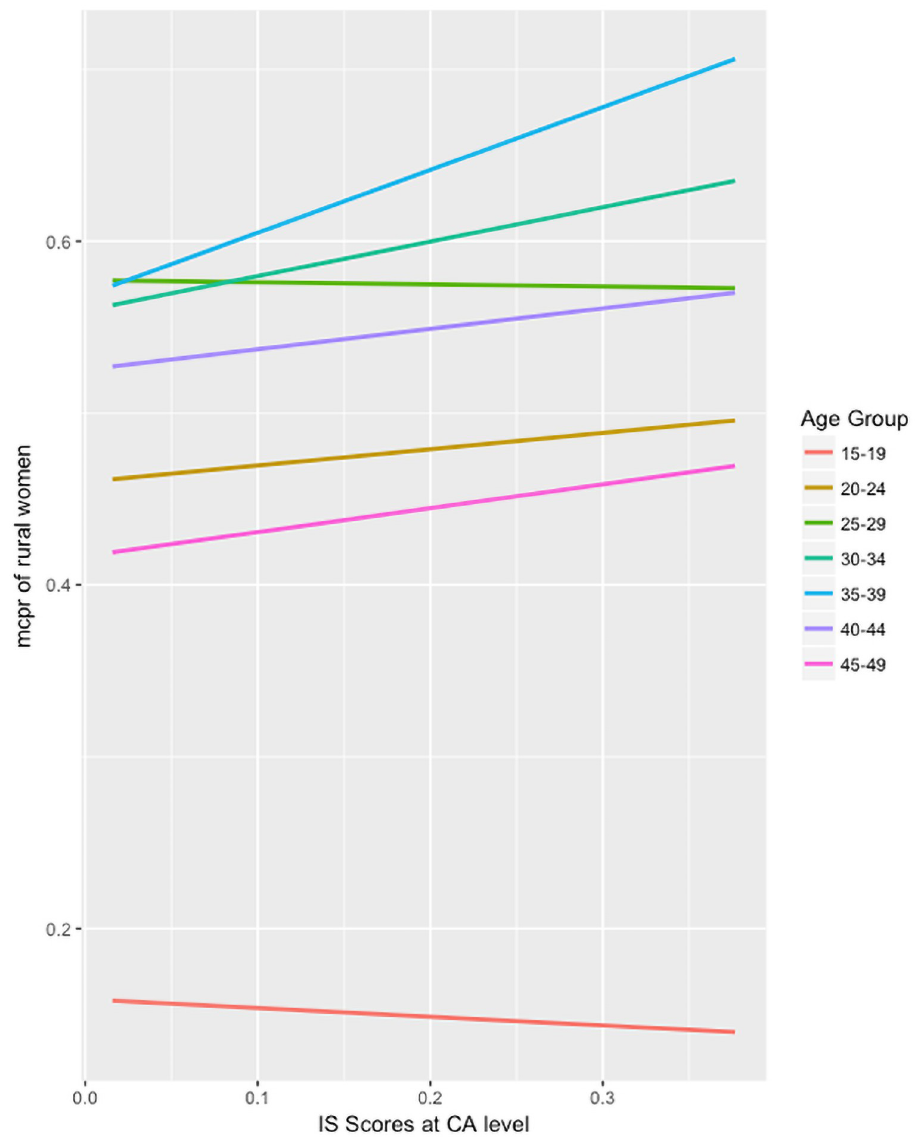
Fig 3. Relationship between implementation strength summary measure and modern contraceptive use among rural women, by age group.